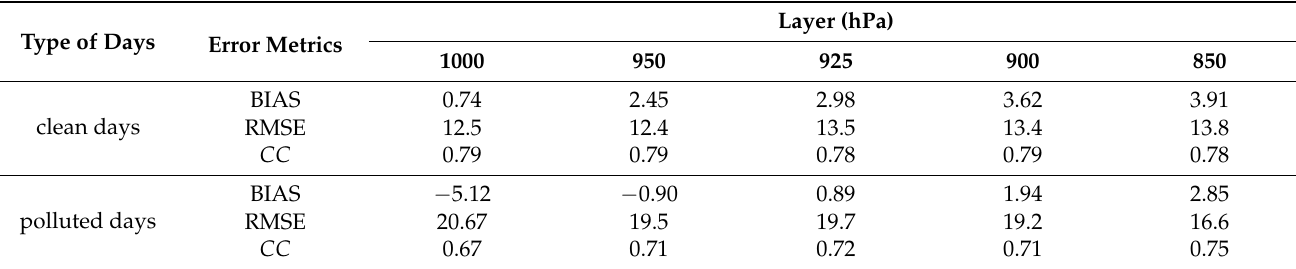
Table 4. Error metrics for the relative humidity in Beijing.